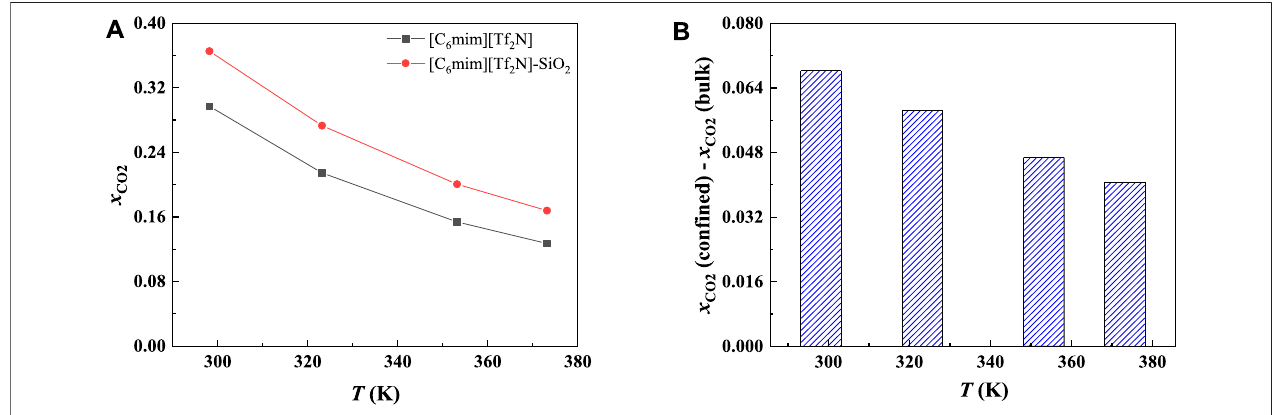
FIGURE 5 | Calculated CO 2 solubility (A) and additional solubilities (B) of ILs con fi ned in 25 Å slit-shaped pore at 10 bar and different temperatures.